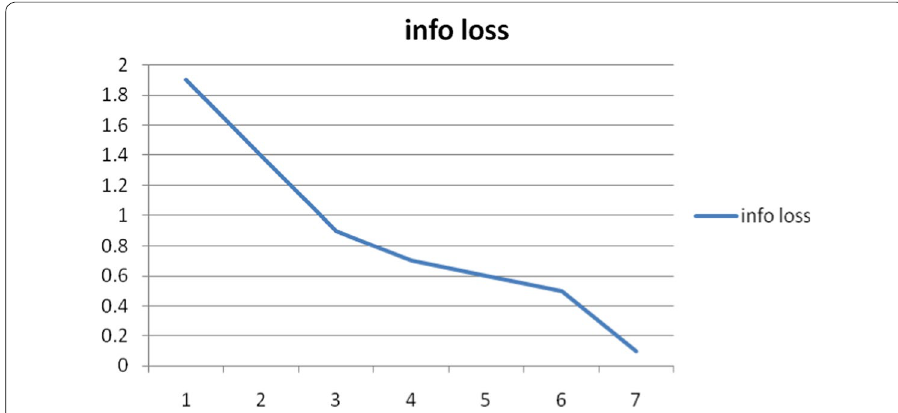
Fig. 11 Info loss with fixed key value (3,2) and variant no. of records